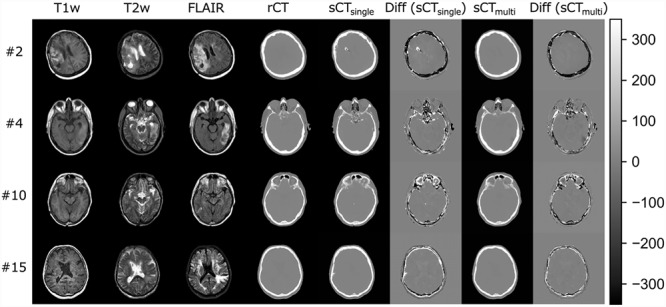
Quantitative comparisons of axial slices between the real and synthetic CT images (rCT and sCT, respectively). Each row shows images of a different representative patient. The sCT images generated from only the T1w sequence (sCTsingle) and from the T1w, T2w and FLAIR MR sequences (sCTmulti) are shown. The difference maps show the differences in CT number between the rCT and sCT images (sCT—rCT) according to the color bar on the right.